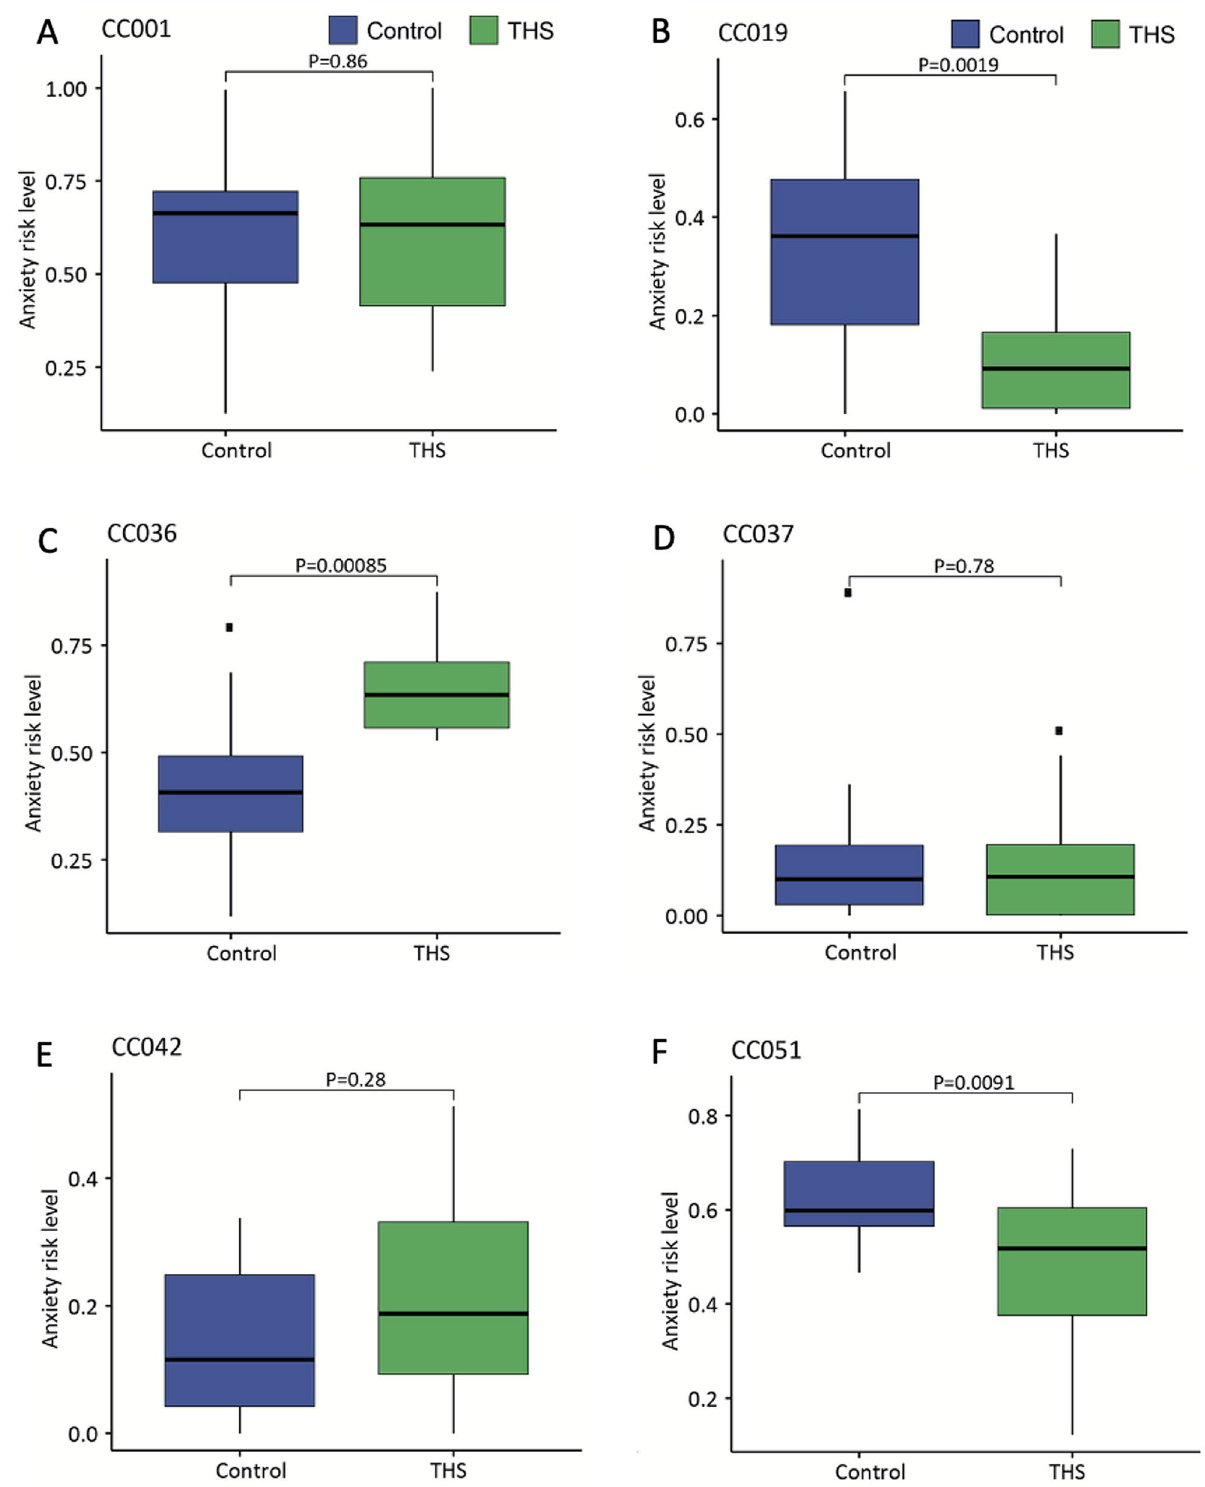
Figure 3. Evaluation of CC mouse anxiety level using the anxiety risk score (ARS). Anxiety risk scores were calculated for control and THS exposed CC001 ( A ), CC019 ( B ), CC036 ( C ), CC037 ( D ), CC042 ( E ) and CC051 ( F ). Bars indicate the 1st and 3rd quartiles and the thick horizontal line indicates the median. Error bars indicate minimum and maximum values excluding outliers. P values were obtained by Mann–Whitney test. A red asterisk indicates a P value <